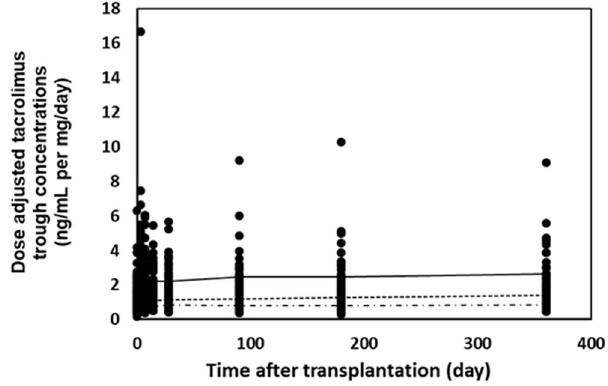
Figure 3. Dose-adjusted tacrolimus trough concentrations in patients after kidney transplantation. Solid, dotted, and dashed lines indicated the mean of dose-adjusted tacrolimus trough concentrations in carriers with